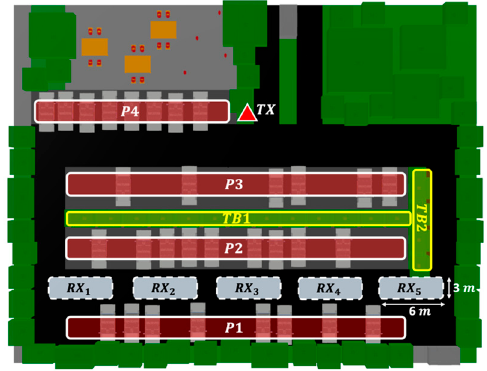
Figure 2. Schematic view of the reception points (RX1 to RX5) and the affected areas: vegetation (TB1 and TB2) and parked vehicles (P1 to P3).